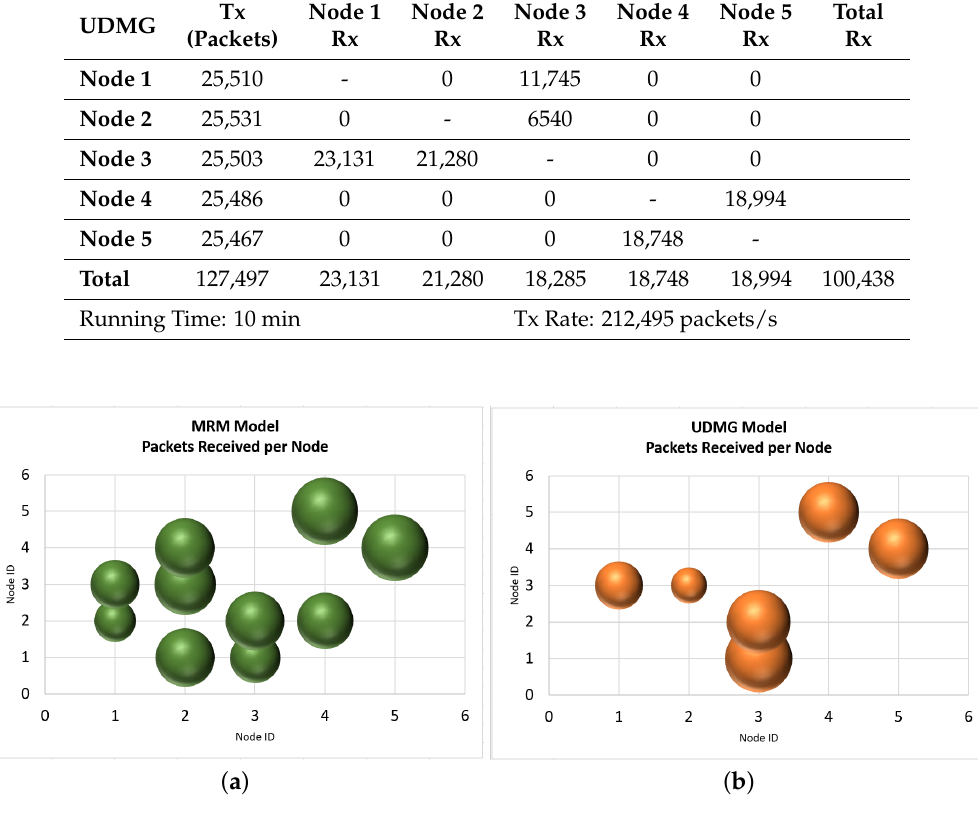
Figure 10. Packets: Cooja built-in models simulation ( a ) MRM Simulation; ( b ) UDMG